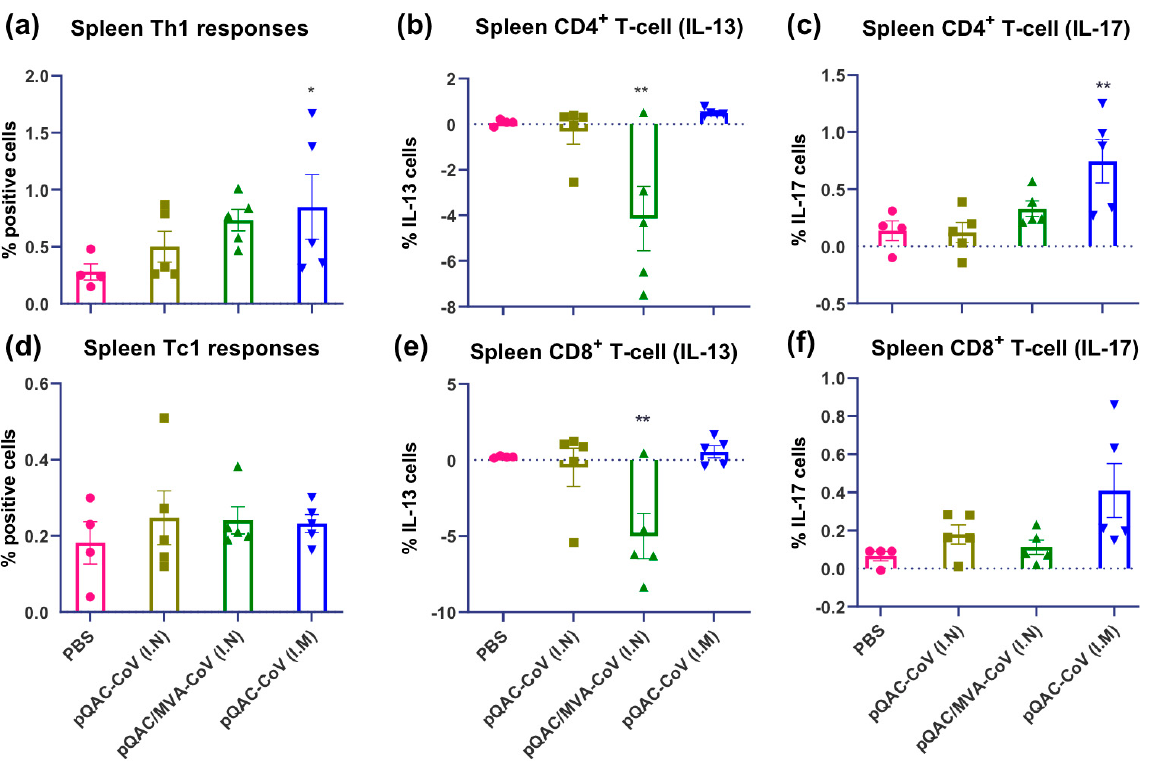
Figure 6. SARS-CoV-2 spike specific T cell responses in spleen of vaccinated C57BL/6 mice. Intracellular cytokine staining was performed on spleens harvested 3 weeks after final boost to assess T-cell responses. ( a ) Type 1 helper (Th1) responses (IFN- γ or TNF α or IL-2+), ( b ) type 2 helper (Th2) responses (IL-13+), ( c ) type 17 helper (Th17) responses (IL-17+), ( d ) type 1 cytotoxic (Tc1) responses (IFN- γ or TNF α or IL-2+), ( e ) type 2 cytotoxic (Tc2) responses (IL-13+), ( f ) type 17 cytotoxic (Tc17) responses (IL-17+) intracellular cytokine staining assays for spleen T-cells in response to recombinant SARS-CoV-2 spike stimulation. Significance (*, p < 0.05; **, p < 0.01) was determined by ANOVA compared to PBS controls. Data show mean ± SEM.